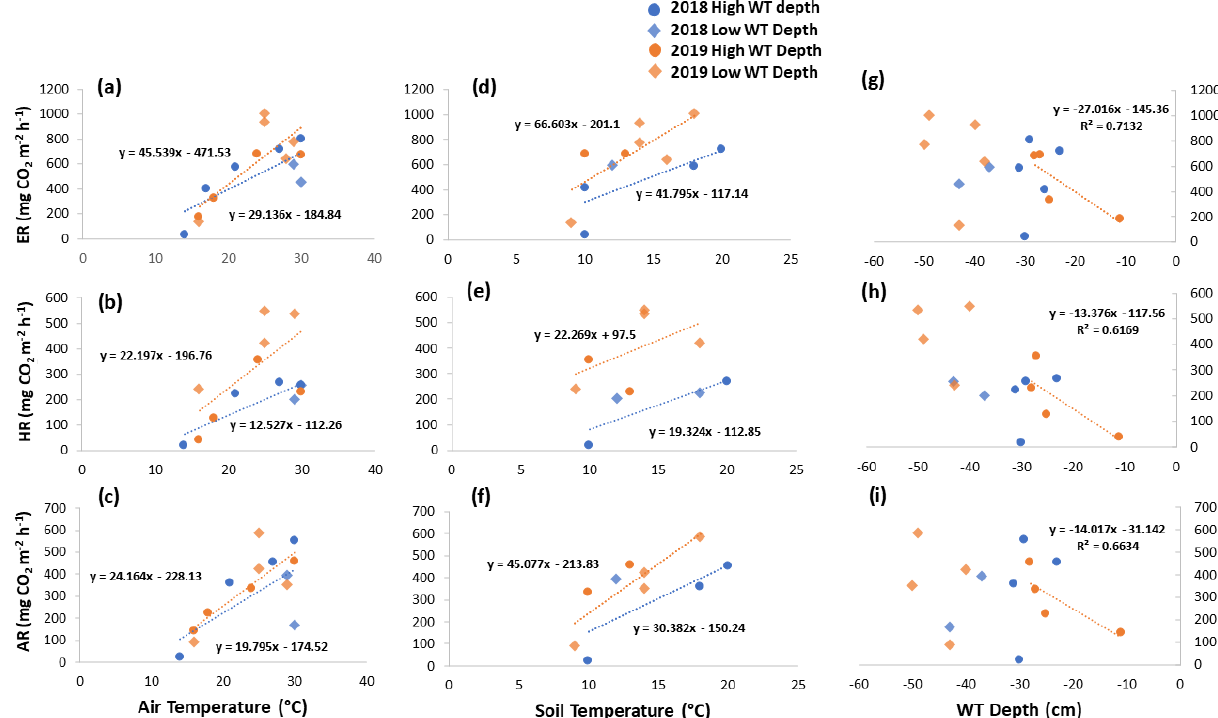
Figure 7. Scatterplots with trend lines of relationships between air temperature and (a) ER, (b) HR, and (c) AR; between soil temperature and (d) ER, (e) HR, and (f) AR; and between water table (WT) depth and (g) ER, (h) HR, and (i) AR in the sedges across the growing seasons of 2018 and 2019. High WT refers to water table positions from surface to 35cm depth.